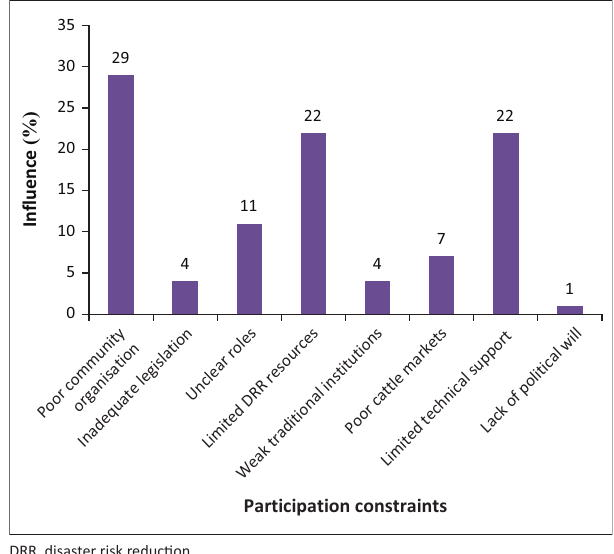
FIGURE 3: Communal farmer participation